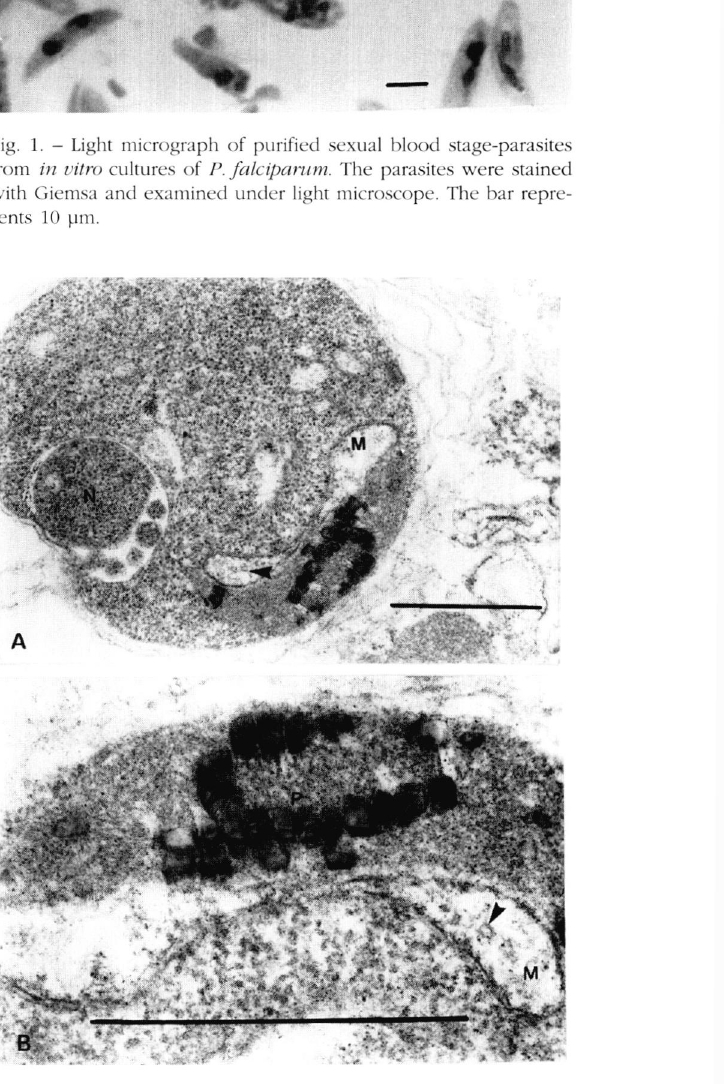
Fig. 2. - Transmission electron micrograph of the asexual tropho zoite stage of P. falciparum. A single mitochondrion is observed with a clearly double membrane organelle, and an elongated form which is preparing for binary fission (A). It is noted that only one tubular cristae structure, marked by an arrowhead, is associated to the orga nelle at higher magnification (B). The bar represents 1 µm. N, nucleus; M. mitochondria: P. crystalline